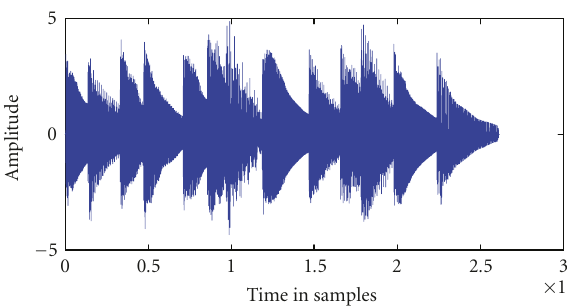
Figure 7: A real piano signal containing twelve onsets is used for showing the e ff ect of the choice of R on the detection performance.